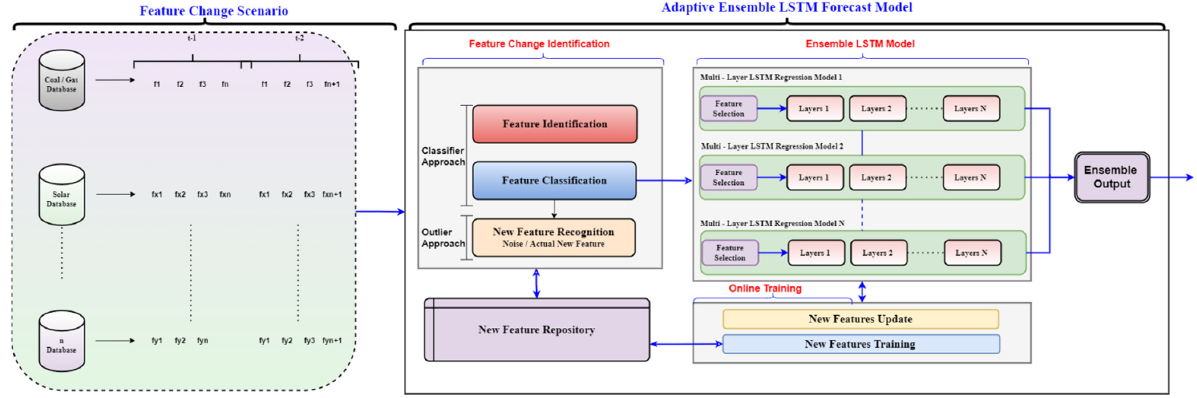
Figure 12. Adaptive Ensemble LSTM forecasting model framework with feature and modality change scenario.